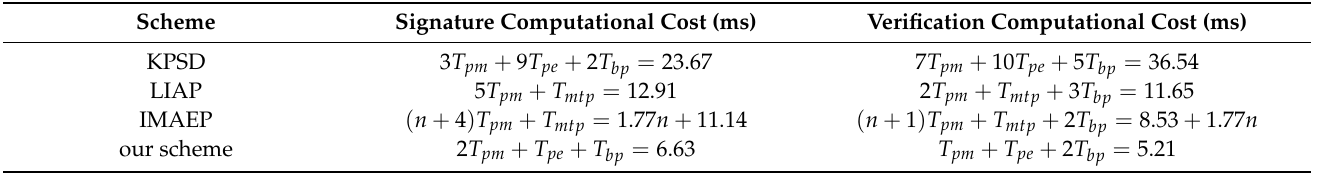
Table 3. The computational costs result of each schemes.